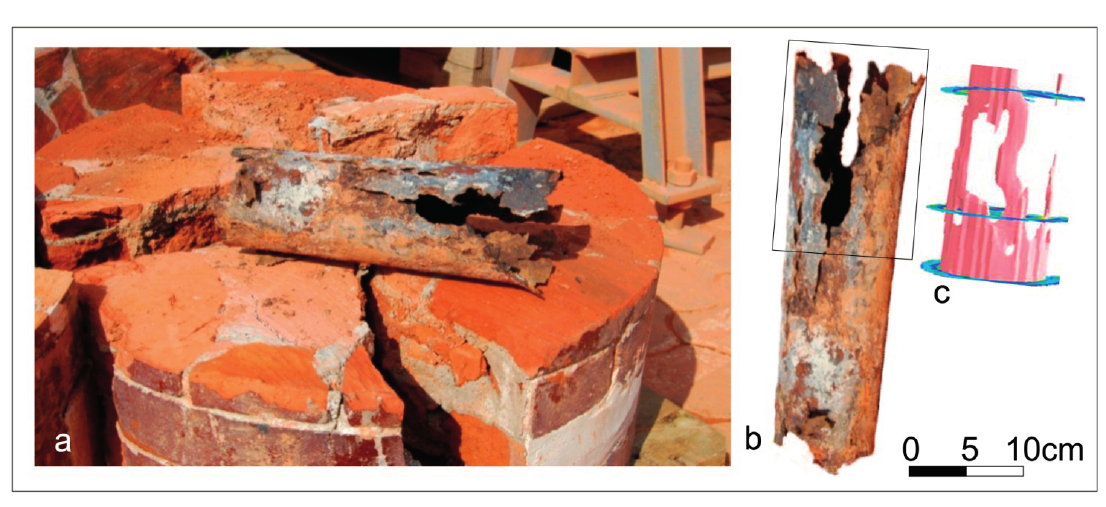
Figure 11. ( a ) Section of the column after the compression test and ( b ) the metallic tube extracted, compared to ( c ) 3D radar imaging from isoamplitudes after a cylindrical